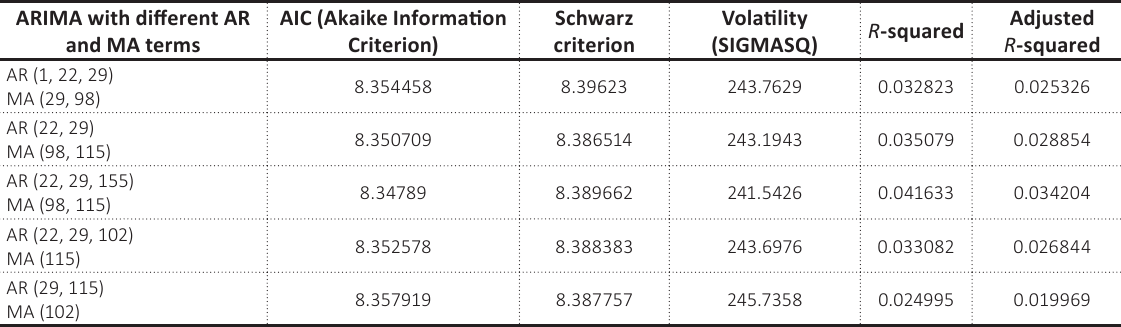
Table 5. Results of the best 5 adjusted ARIMA models for Lupin